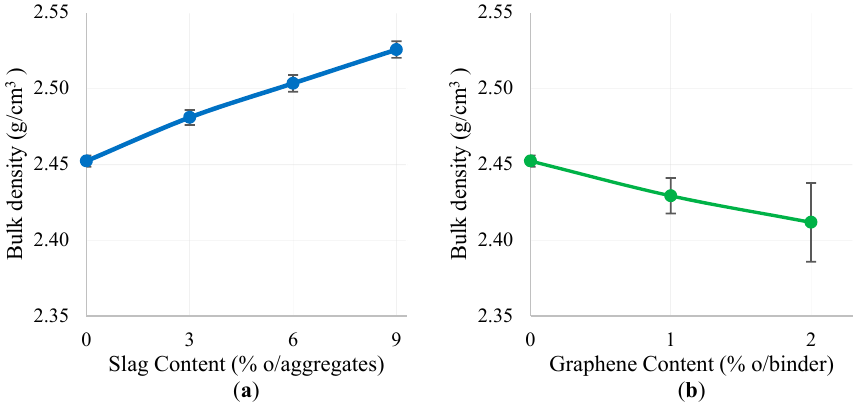
Figure 9. Effect of slag ( a ) and graphene ( b ) on the bulk density.